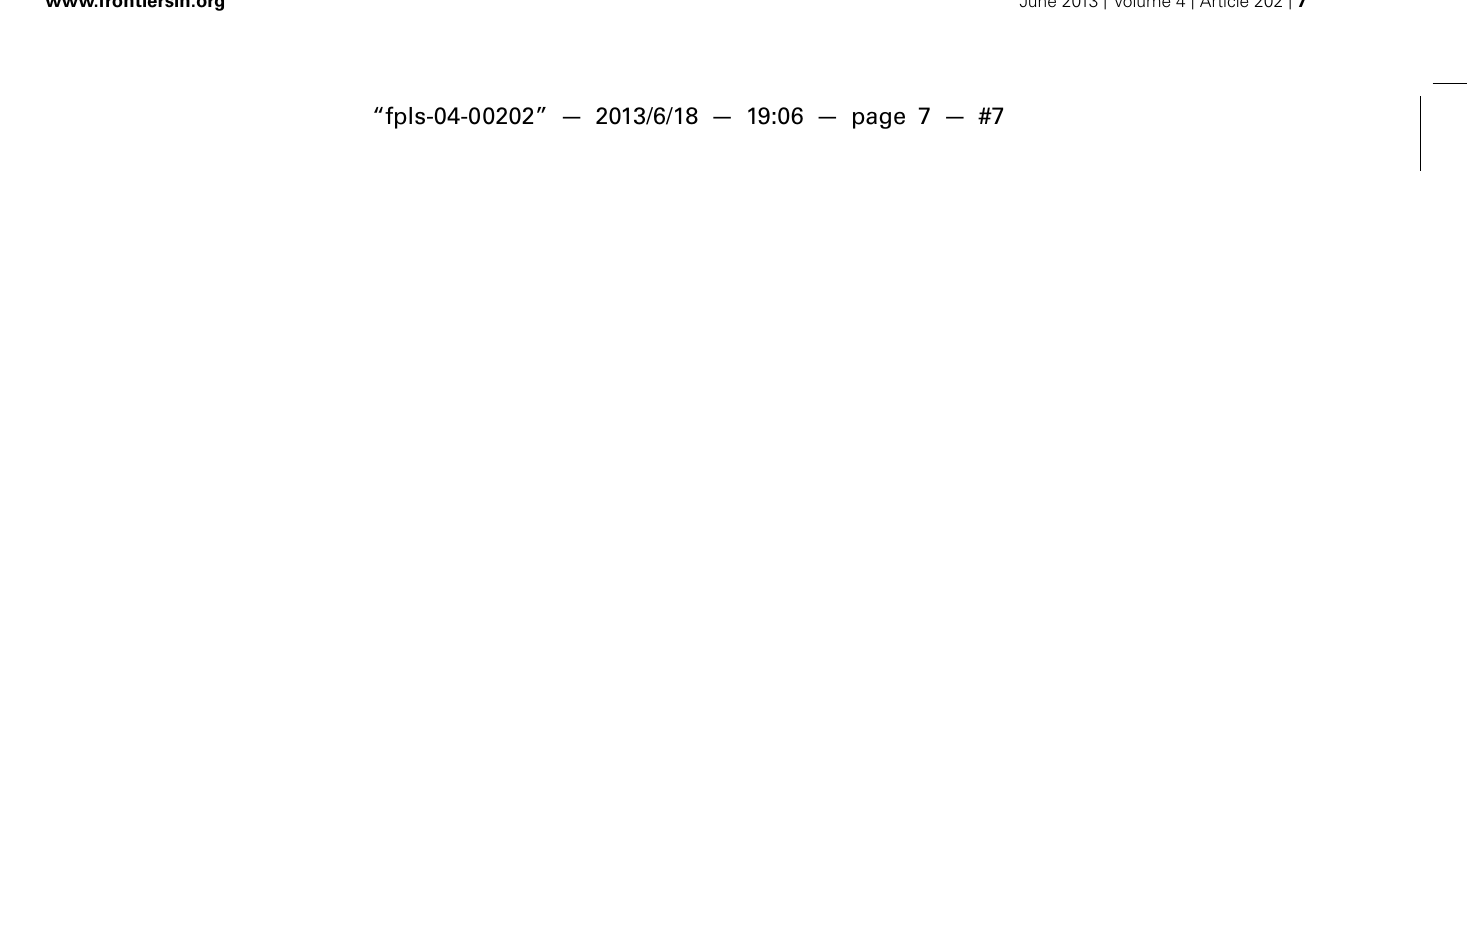
FIGURE 4 | One-way clustering color map for class III peroxidase expression profiles (z-scores) for NGS datasets for crowns and rhizomes obtained from field-grown Summer plants at theAgricultural Research and Development Center fields of the University of Nebraska. Harvest months are shown and coincided approximately with green-up (May), late vegetative stage (June), flowering (July), hard-seed stage (Aug), and aerial senescence after a killing frost (Oct). Red indicates high abundance, yellow is intermediate and green and blue are low or negligible abundance.The appropriate SRA identification numbers for these individual NGS files are shown in TableA1 in Appendix.The six clusters of the most abundant transcripts from each harvest date are shown (C1–C6) along with the numbers of individual peroxidases as assigned to an evolutionary